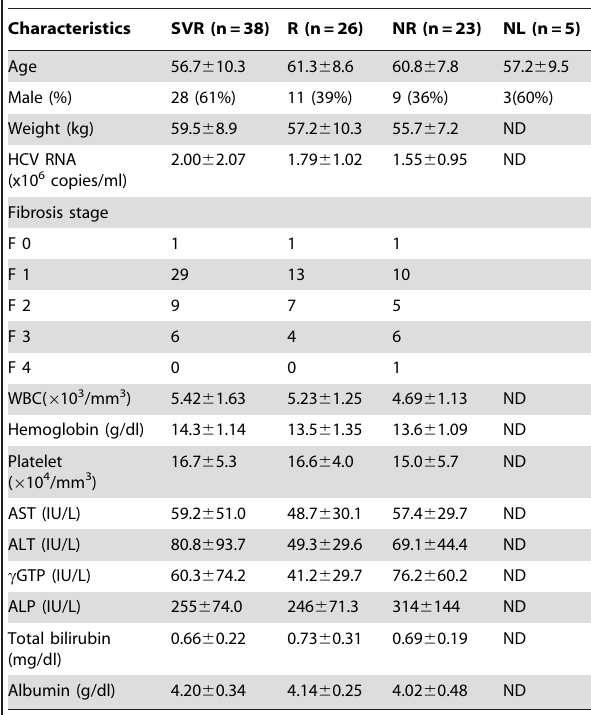
Table 1. Clinical characteristics of